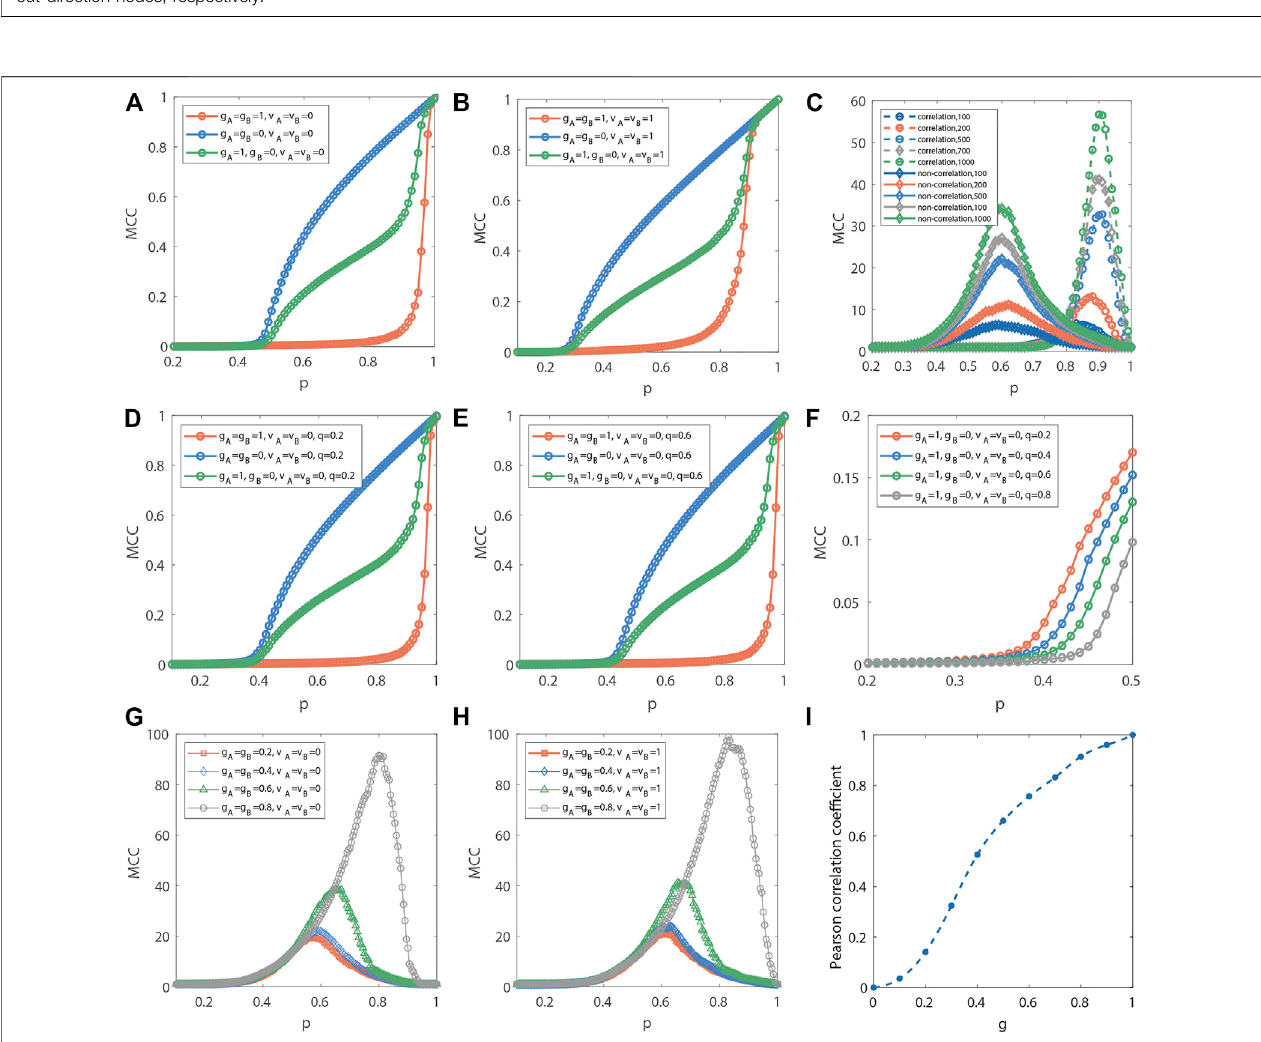
FIGURE3| Targetedattack inarti fi cial networks. (A,B) Targeted attacks ondifferentkindsofsynthetic networks withN (cid:1) 5,000. (C) Thesizeofthe2nd-MCC asa function of p for different sizes N. we set g A (cid:1) g A (cid:1) 1, r A (cid:1) r A (cid:1) 0 in the correlation case and g A (cid:1) g A (cid:1) 0, r A (cid:1) r A (cid:1) 0 in the non-correlation case. (D – F) Targeted attacks on three kinds of synthetic networks with coupling strengths q . (G,H) Simulate targeted attack with different intra-layer angular correlations, and N (cid:1) 500. The results are averages over 100 realizations. (I) illustrates the relationship between parameter g and Pearson correlation coef fi cient in the arti fi cial model.